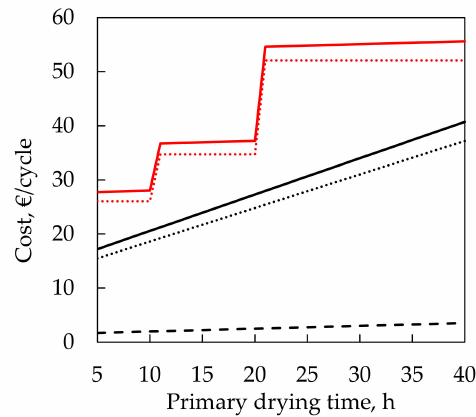
Figure 5. Evolution of the costs of a freeze-drying cycle conducted with a laboratory lyophilizer. It is possible to see how the operational costs (black dashed line) consist of a small fraction of the capital costs, calculated when considering either a 7-day (black dotted line) or a 5-day (red dotted line) working week. The total costs (solid lines) reflect, therefore, the behavior of the capital